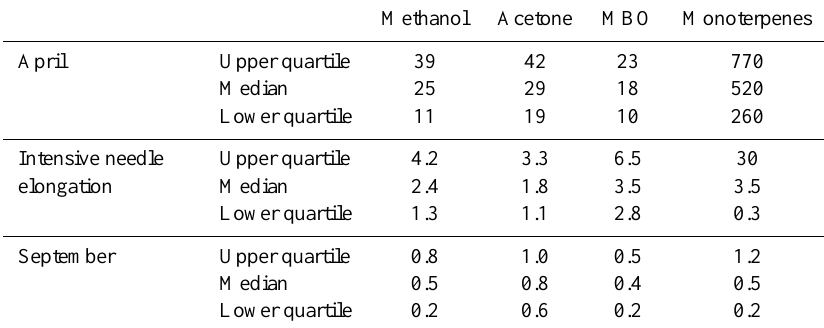
Table 1. The ratio between the VOC emission rate of the growing needles to the emission rate of mature needles (unitless), obtained by dividing the daily average emission rate of growing needles with the daily average emission rate of mature needles. The medians represent data from all three measurement years, and the periods cover April, the most intensive needle elongation days (needle elongation rate ≥ 0.5mmd − 1 , in June and July), and September.